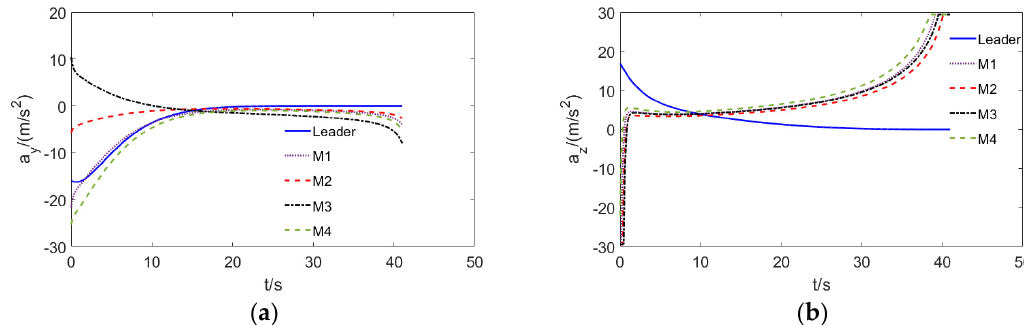
Figure 19. Normal acceleration curves obtained by the time cooperative guidance algorithm: ( a ) Normal acceleration curve of the dive plane; ( b ) Normal acceleration curve of turning plane.